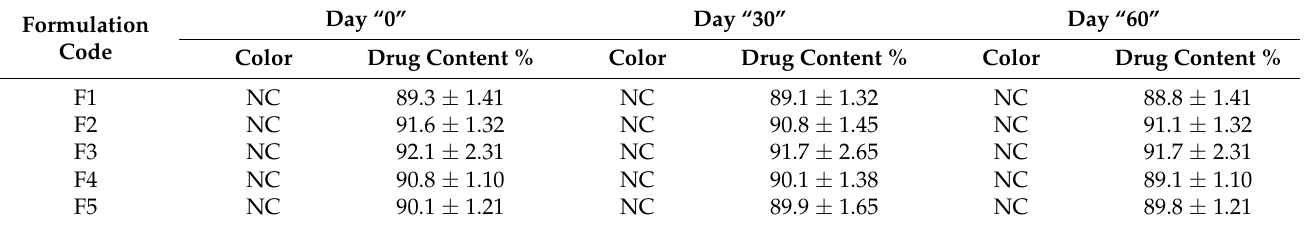
Table 5. Stability of formulations (F1–F5) at accelerated temperature at 40 ◦ C ± 2/75% ± RH. Data are expressed as mean ± SD ( n = 3). Formulation